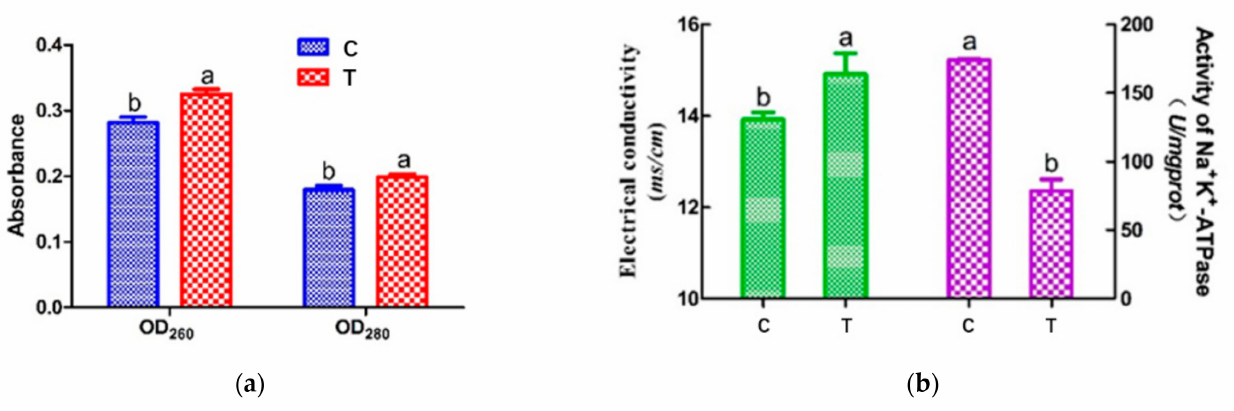
Figure 2. The intracellular nucleic acid (260 nm) and protein (280 nm) leakage ( a ) and the electrical conductivity and activity of Na + K + -ATPase ( b ) in A. johnsonii after HVEF treatment. Different letters (a, b) indicate significant differences between control and HVEF-treated samples. ( p <